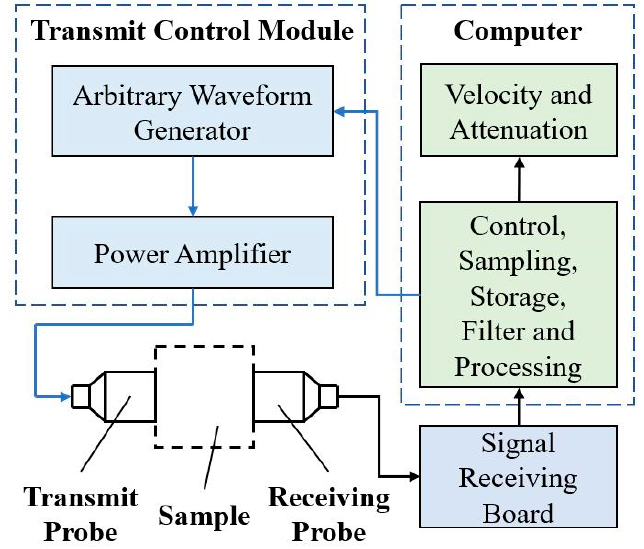
Figure 1. Ultrasonic transmission system.